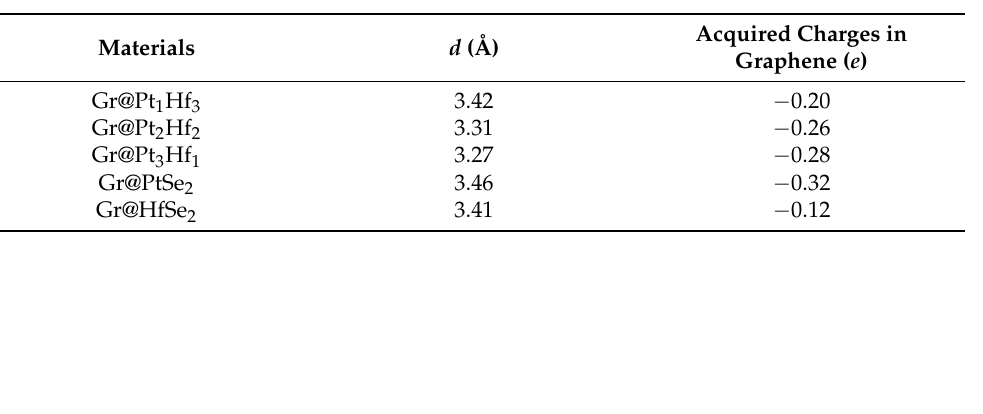
Figure 5. Projected band structures of bidirectional heterostructures of ( a ) Gr@Pt 1 Hf 3 , ( b ) Gr@Pt 2 Hf 2 , and ( c ) Gr@Pt 3 Hf 1 . Projected band structures of ( d ) Gr@PtSe 2 and ( e ) Gr@HfSe 2 . Table 2. Interfacial distance, d (Å), and acquired charges, ( e ), of graphene in the fully